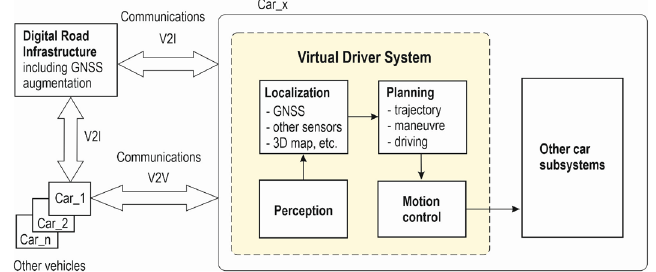
Figure 5. Logical model of automated car